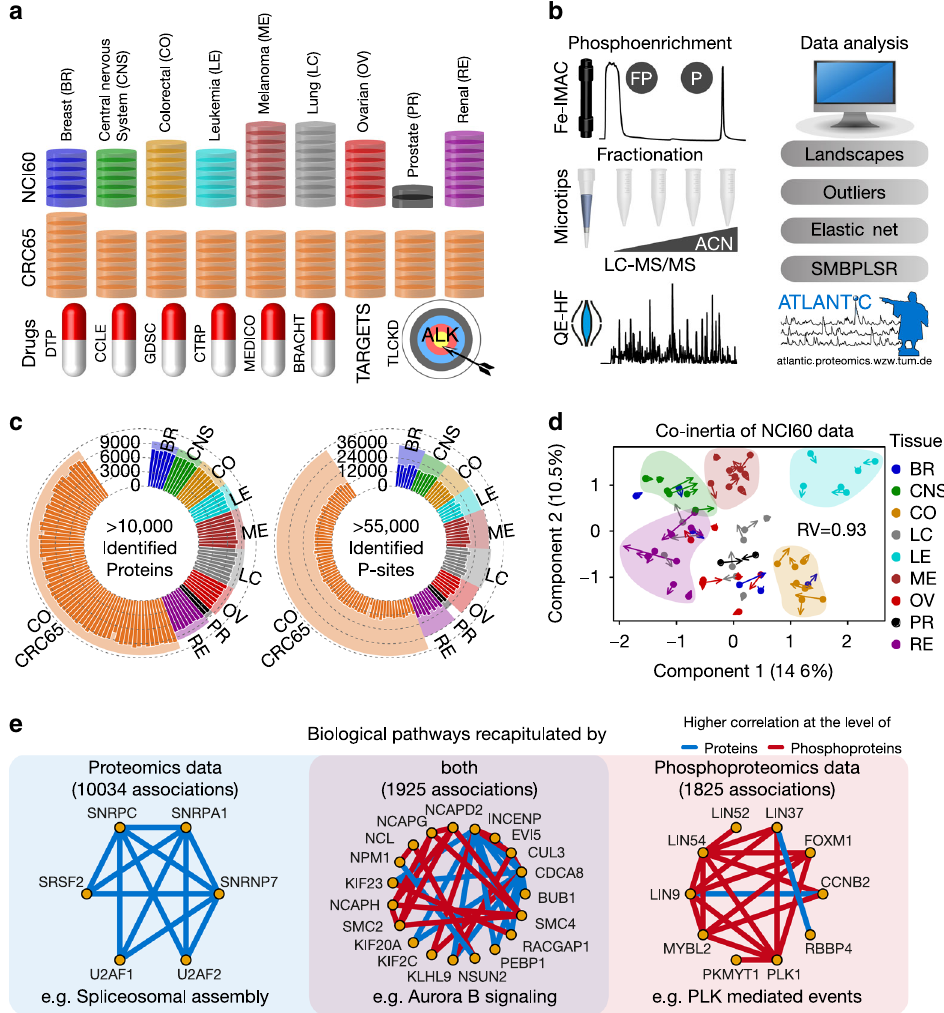
Fig. 1 Proteome and phosphoproteome pro fi ling of 125 tumor cell lines. a Overview of the datasets included in this study, covering the NCI60 ( n = 60 cell lines) and CRC65 cell line panels ( n = 65 cell lines), six public drug-sensitivity datasets and a dataset containing drug targets of clinical kinase inhibitors (see Supplementary Methods for details on all datasets). Cell lines are colored by tissue of origin. This color scheme is consistent across fi gures. b Schematic representation of the biochemical and data analysis work fl ows. FP and P denote full proteome and phosphoproteome, respectively. The results can be explored interactively on the ATLANTiC website. (ACN = acetonitrile, SMBPLSR = sparse multiblock partial least squares regression) c Circular bar plot showing the number of identi fi ed proteins and p-sites per cell line ( n = 125 cell lines). Shaded areas indicate the sum of the proteins and p-sites within each tumor entity. We identi fi ed a grand total of >10,000 protein groups and >55,000 p-sites. d Multiple co-inertia analysis of phospho- and full proteome data of the NCI60 panel showing the fi rst two components ( n = 59 cell lines). Bases and ends of arrows represent the full proteome and phosphoproteome data of a given cell line, respectively. Short arrows indicate a good correlation between phospho- and full proteome. The RV coef fi cient quanti fi es the correlation of two matrices analogous to the Pearson correlation coef fi cient. A RV close to 1 indicates high correlation. e Representative pathways signi fi cantly (Fisher ’ s exact test; Benjamini – Hochberg corrected P < 0.05) enriched in functional associations recapitulated by our proteomics data (left panel), phosphoproteomics data (right panel) or both (middle panel). Source data are provided as a Source Data fi